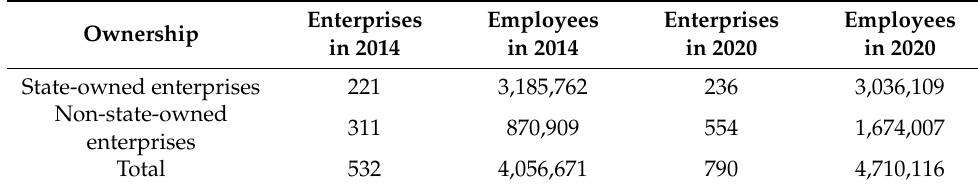
Table A2. The number of enterprises and employees by ownership.